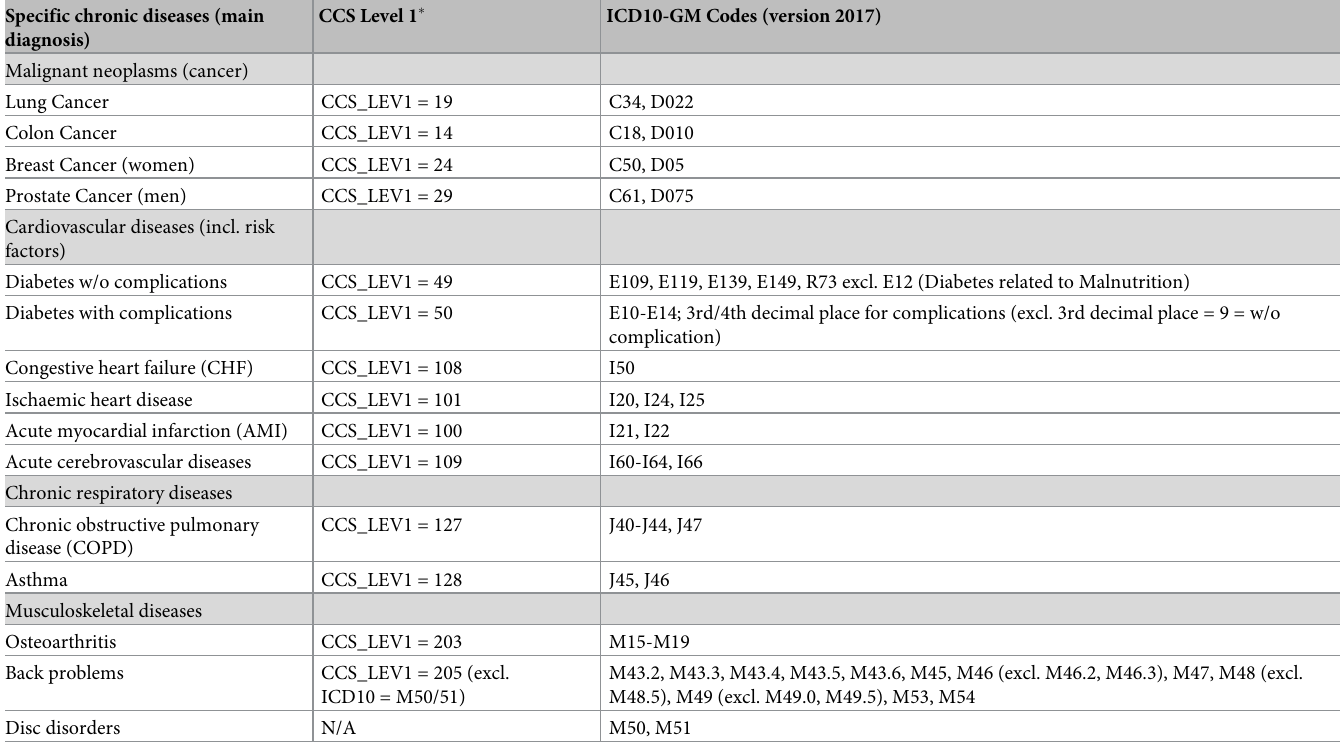
Table 1. Definition of specific chronic diseases based on main diagnosis during